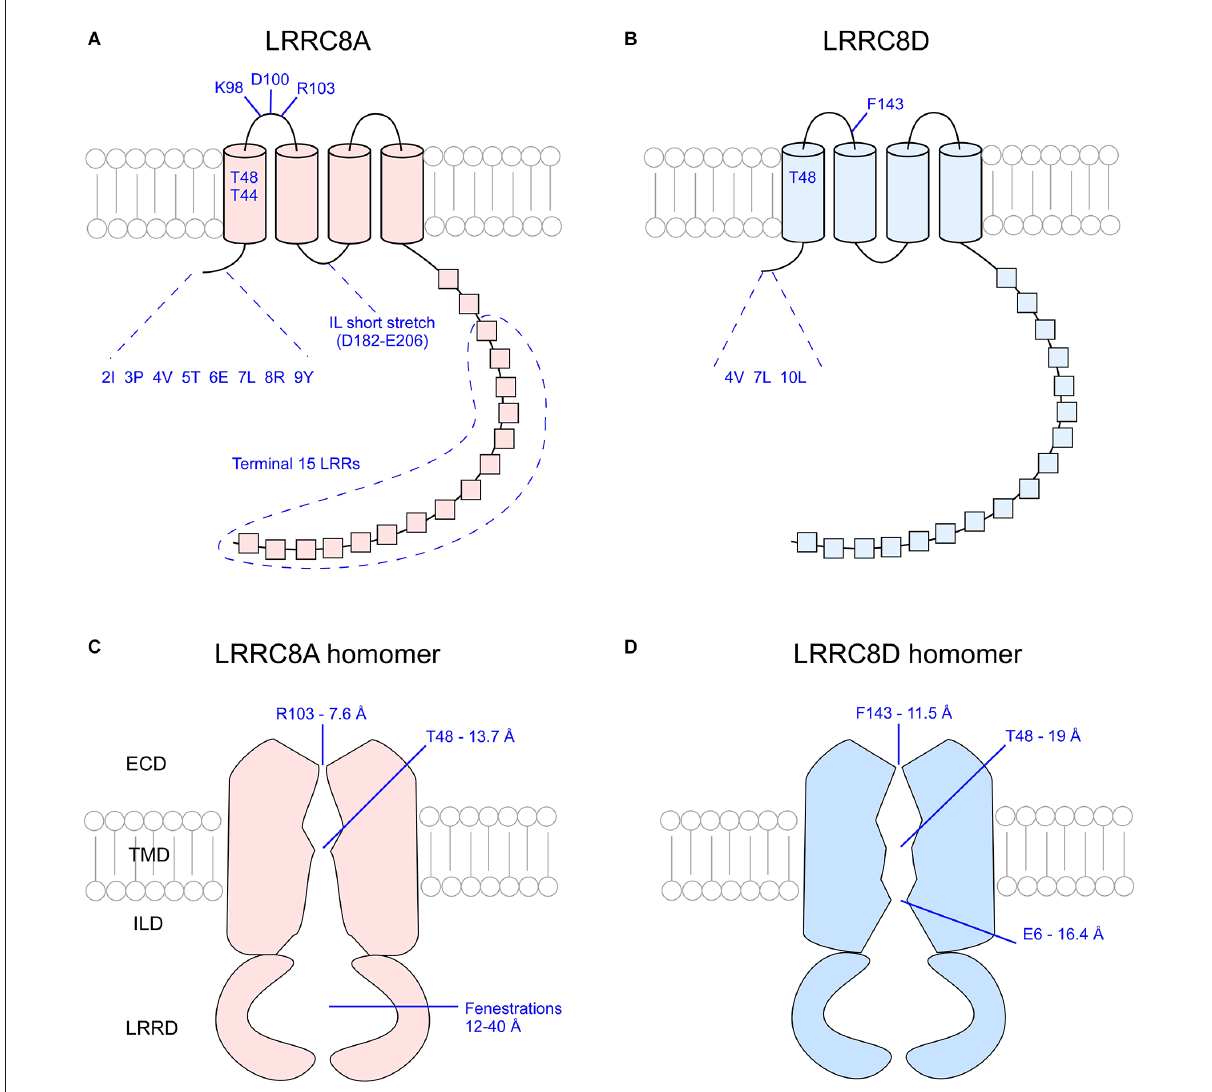
FIGURE4 Overview of critical pore-defining amino acid residues of the LRRC8A and LRRC8D subunits as determined by cryo-EM and functional analysis experiments. Critical residues of singular LRRC8A (A) and LRRC8D (B) subunits. Visualization of the constrictions of the pores of LRRC8A homomers (C) and LRRC8D homomers (D) . ECD, extracellular domain; TMD, transmembrane domain; ILD, intracellular linker domain; IL, intracellular loop; LRR, leucine rich repeat; LRRD, leucine rich repeat